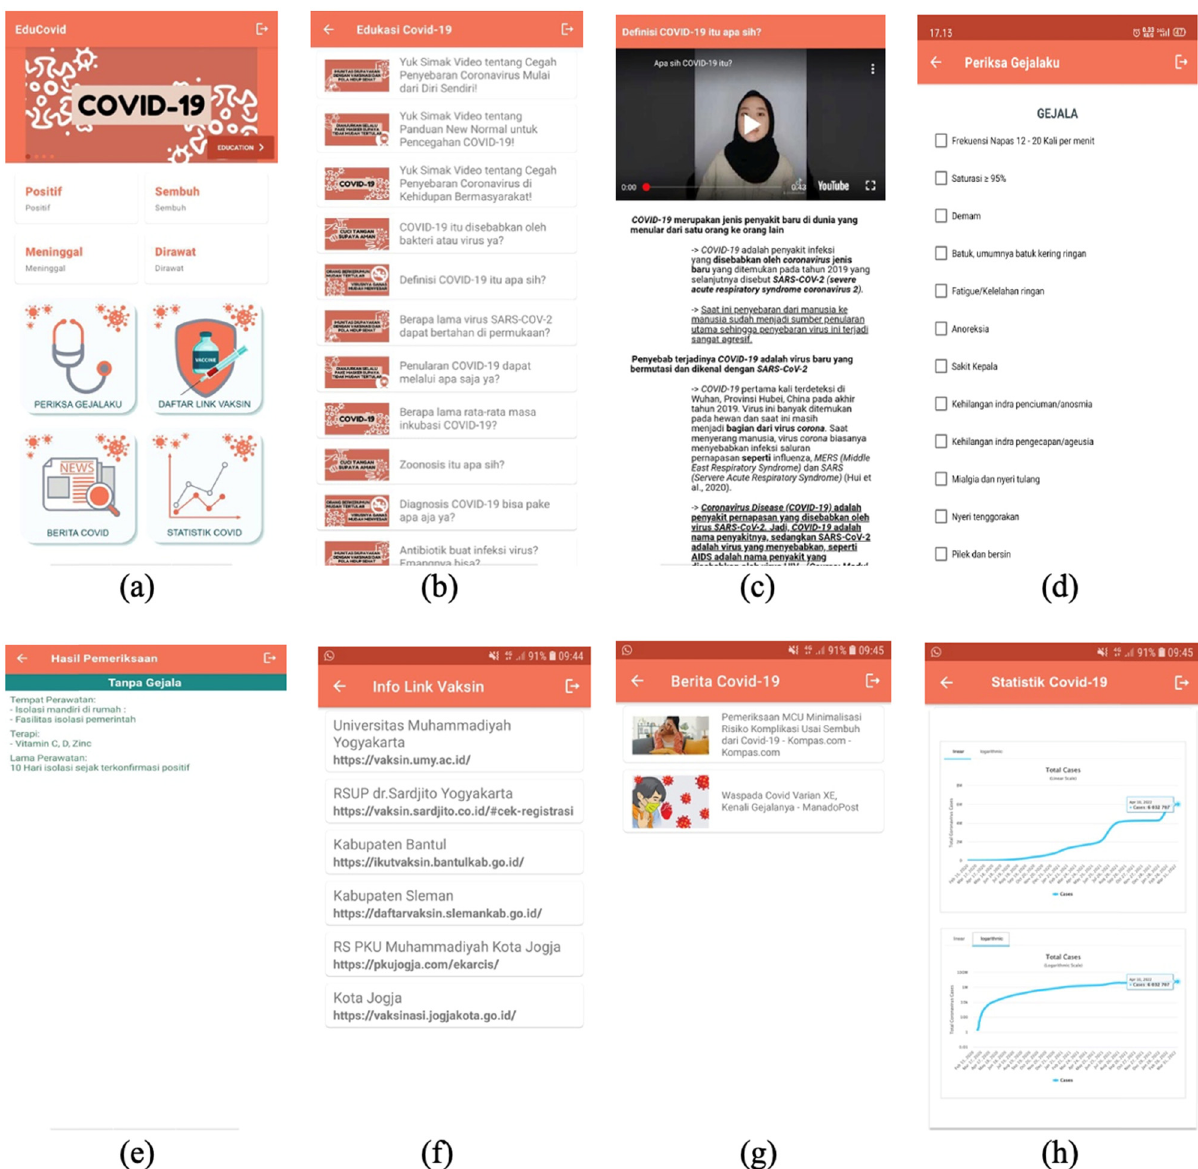
Figure 3: Screenshots of user interface of the Educovid - 19 app, including ( a ) the main menu containing many features and functions; ( b ) the list of educational materials; ( c ) the details of the educational material; ( d ) the symptom checker page; ( e ) the results of the symptom checker; ( f ) the list of vaccine information links; ( g ) the latest news on COVID - 19; and ( h ) COVID - 19